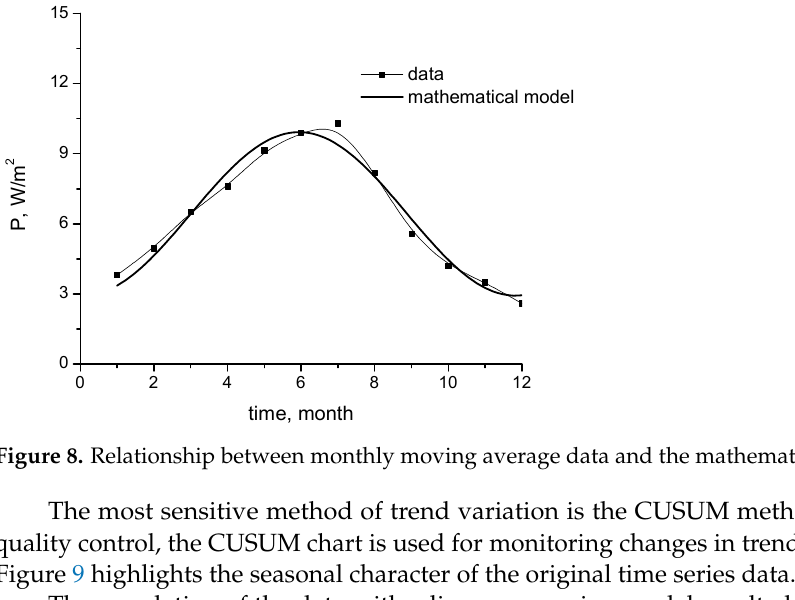
Figure 7. The moving average ( n = 6) applied to the monthly average data.